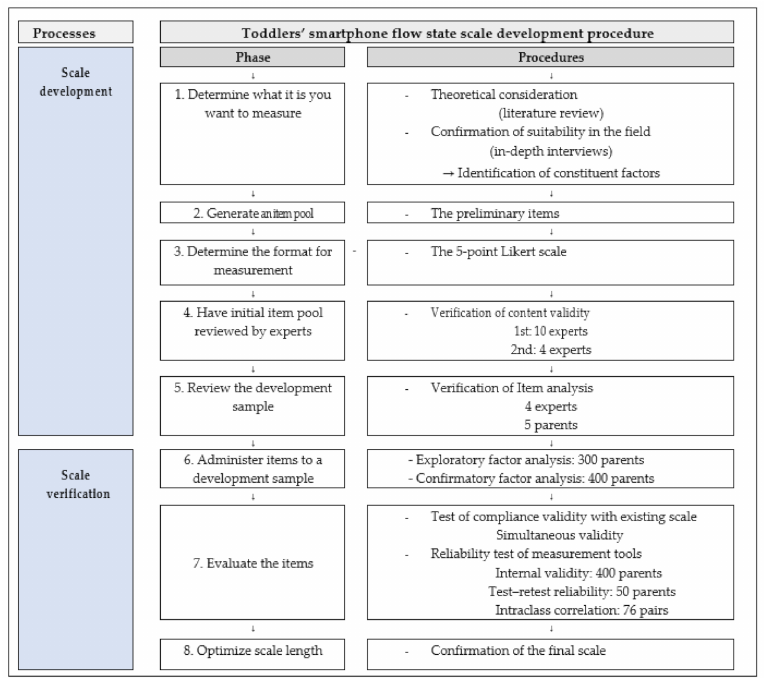
Figure 1. Research procedure. The Toddlers’ Smartphone Flow State Scale (TS-FSS) was developed and validated according to DeVellis’ eight stages of scale development.2.2. Generate an Item